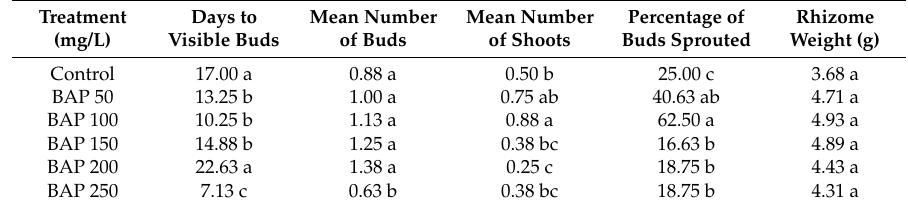
Table 2. The effect of different concentrations of 6-benzylaminopurine (BAP) on the number of days to visible buds, mean number of buds, mean number of shoots, percentage of buds sprouted, and rhizome weight of Z. zerumbet .